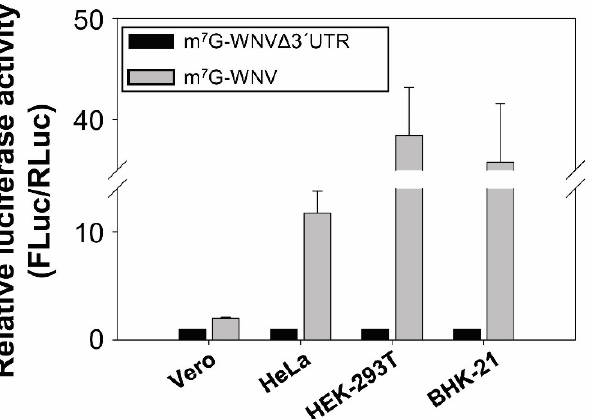
Figure 3. Translation enhancing effect of the 3 ′ UTR of the WNV genome in different mammalian cell lines. Different cell lines were cotransfected with the capped or uncapped RNA constructs harbouring the 5 ′ end of the WNV RNA genome fusion at the 5 ′ end of the FLuc RNA sequence followed, or not, by the WNV 3 ′ UTR and m 7 G-RLuc RNA. Translation activity was determined as described in Figure 1. Values refer to that of the corresponding construct lacking the WNV 3 ′ UTR, and are the mean of three independent experiments ± standard deviation.